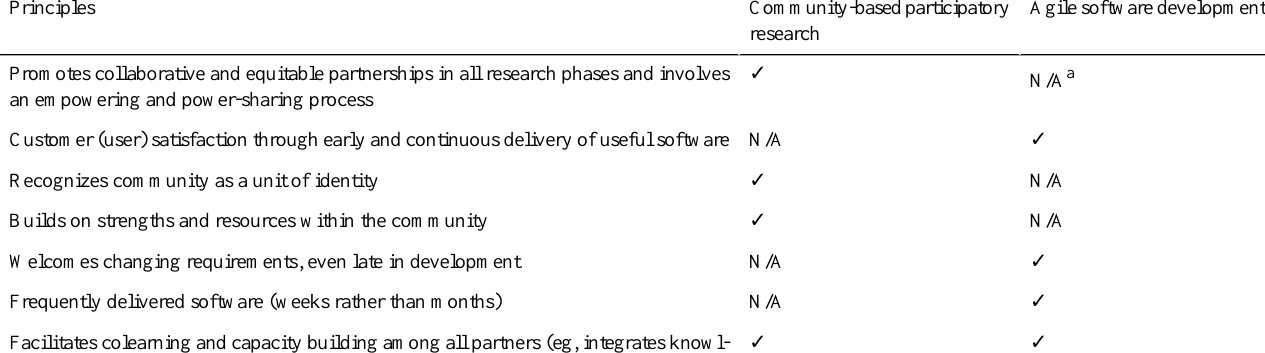
Agile software developmentCommunity-based participatory